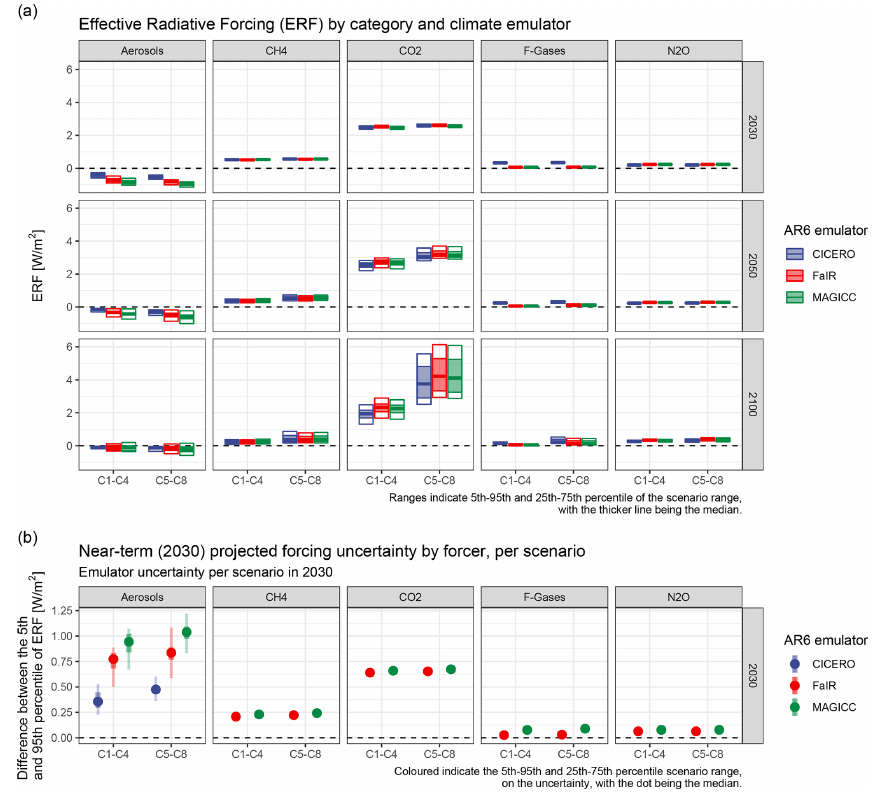
Figure 4. (a) Effective radiative forcing (ERF) statistics across AR6 scenario database subsets as categorised by AR6WGIII using MAGICC for CO 2 , CH 4 , F-gases, and aerosols at different points in time for three climate emulators. (b) Climate uncertainty for every scenario as represented in projected ERF in 2030 for each climate emulator, with a range representing the 5th to 95th percentile range across scenarios. For aerosols this uncertainty in forcing is still relatively unconstrained and depends heavily on the magnitude and mix of emissions within a